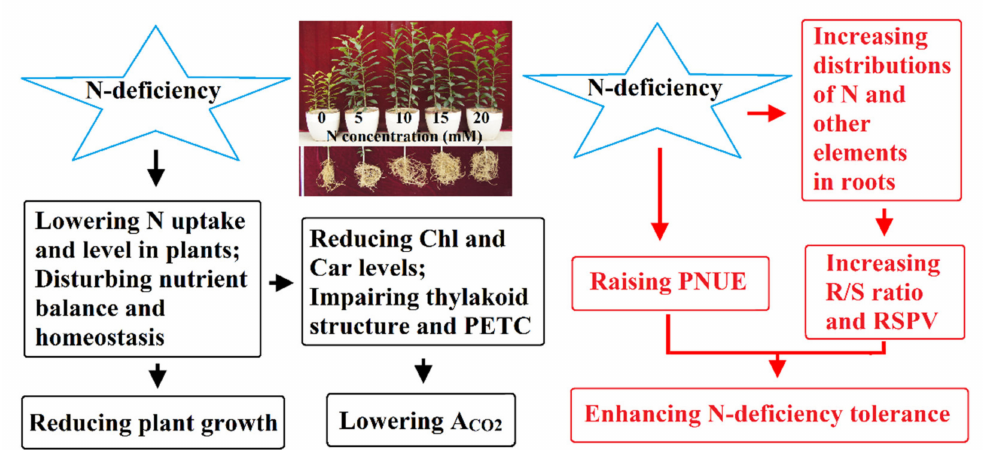
Figure 11. A diagram for the physiological response of C. grandis and C. sinensis seedlings to N deficiency. A CO2 , CO 2 assimilation; Car, Carotenoids; Chl, chlorophyll; N, nitrogen; PETC, photosynthetic electron transport chain; PNUE, photosynthetic N use efficiency; R/S, root DW/shoot DW; RSPV, root-surface-per-unit volume. Supplementary Materials: The following are available online at https://www.mdpi.com/article/10 .3390/agronomy11091859/s1, Figure S1: Effects of nitrogen (N) supply on growth of Citrus sinensis